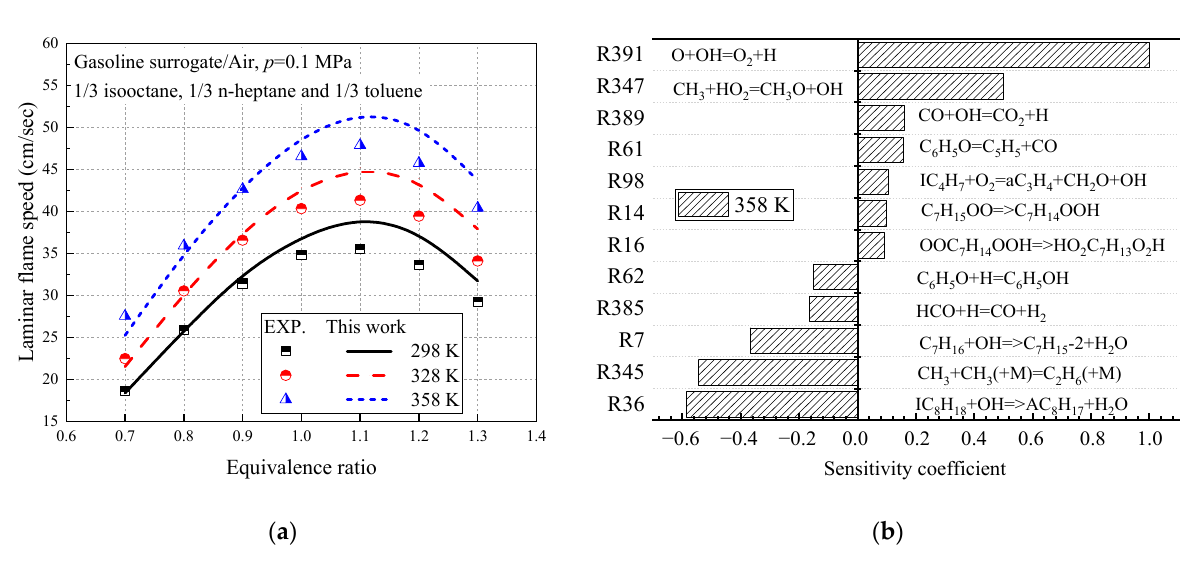
Figure 7. Prediction of laminar flame speed and temperature-sensitivity coefficient of TRF fuel. ( a ) Prediction of laminar flame speed and ( b ) temperature-sensitivity coefficient.